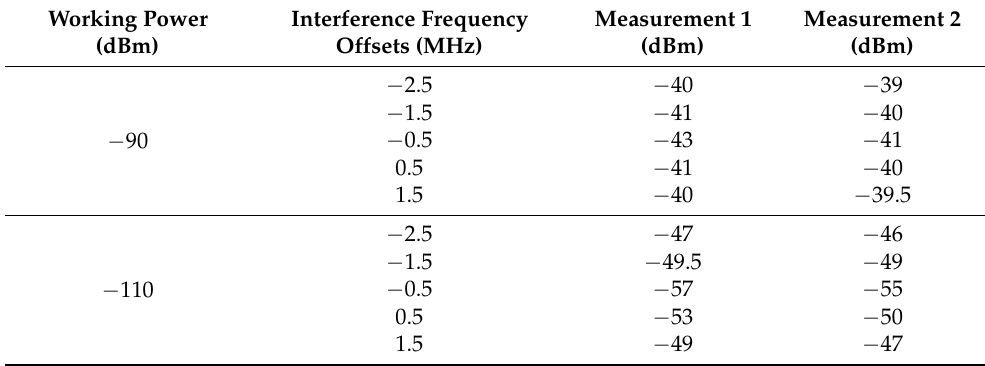
Table 3. Measurement values of critical interference power without regard to loss of positioning duration.